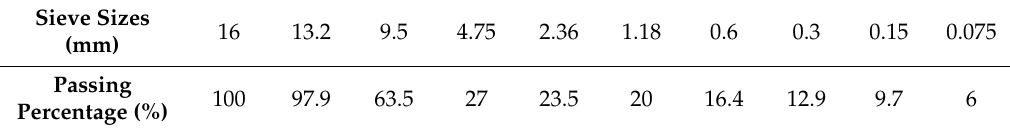
Table 10. Gradation for asphalt rubber Stone Matrix Asphalt (AR-SMA).